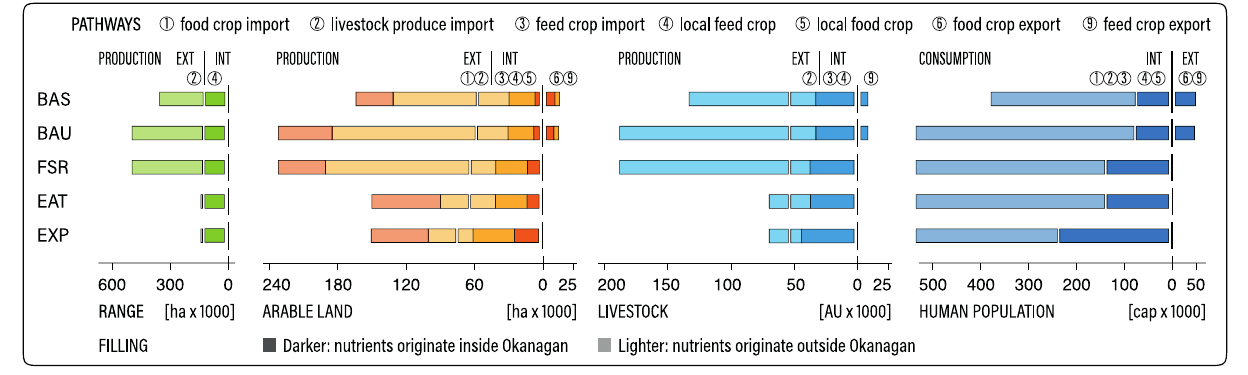
FIGURE 5 | Production of agricultural commodities and consumption of food commodities across food system scenarios. Circled numbers at the top of the figure refer to pathways as per Figure 4 .